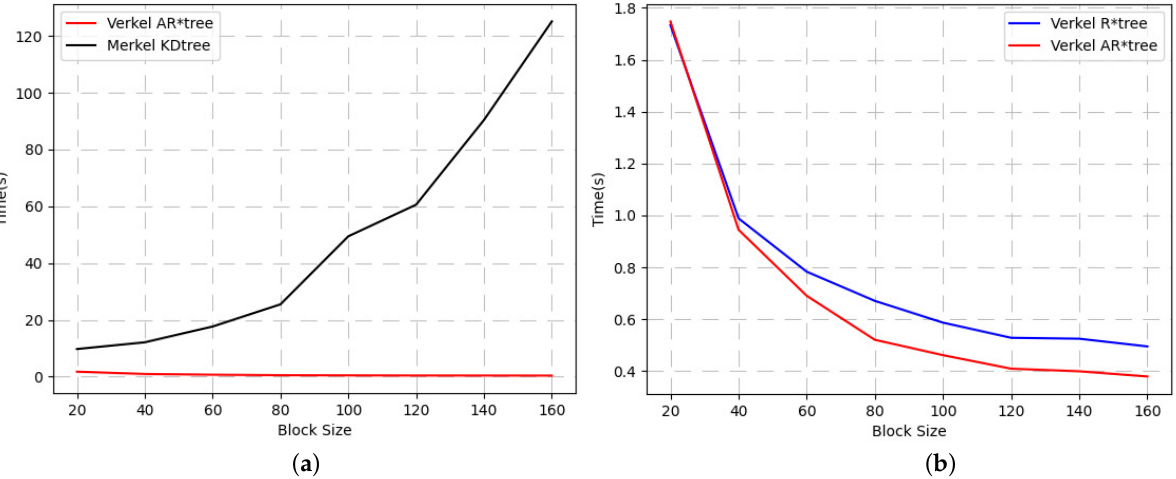
Figure 8. Query performance under different block sizes for cube objects. ( a ) Merkle KD-tree and Verkle AR*-tree. ( b ) Verkle R*-tree and Verkle